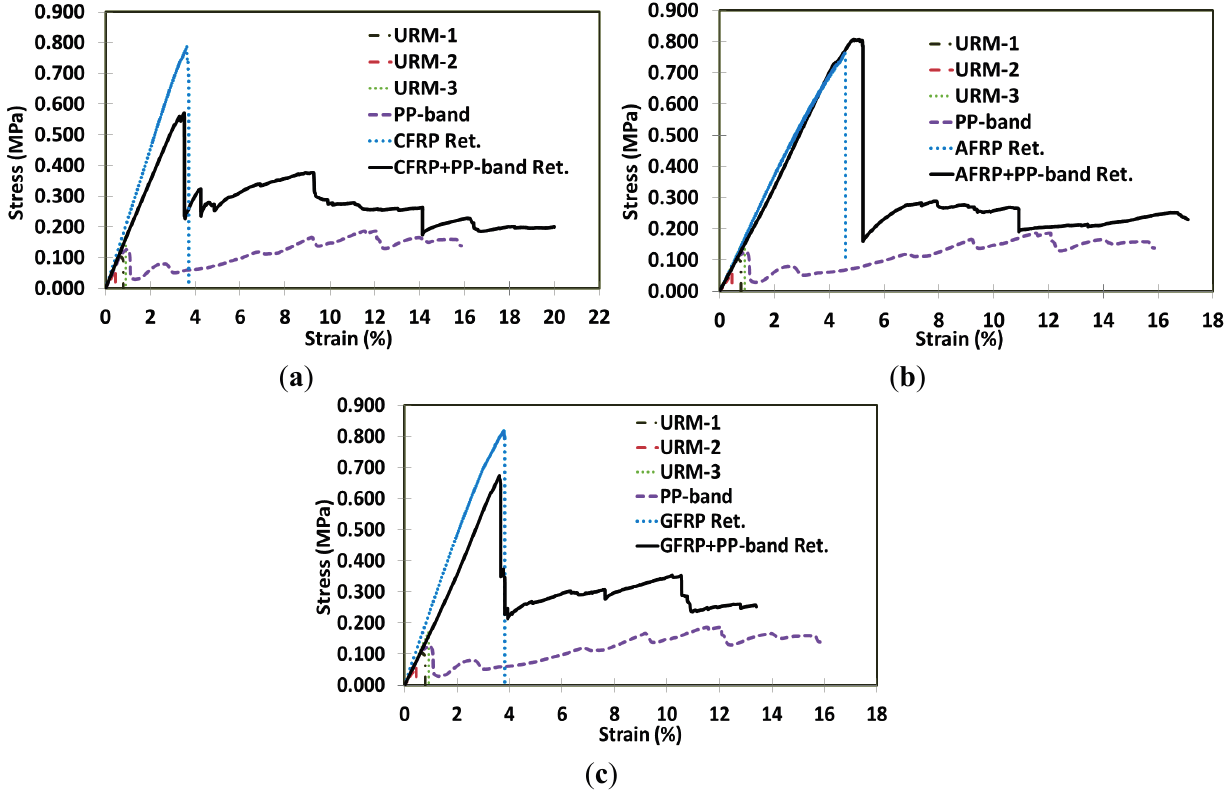
Figure 2. Stress-strain curves of URM and PP-band retrofitted masonry panels along with, ( a ) CFRP and CFRP + PP-band retrofitted masonry panels, ( b ) AFRP and AFRP + PP-band retrofitted masonry panels, and ( c ) GFRP and GFRP + PP-band retrofitted masonry